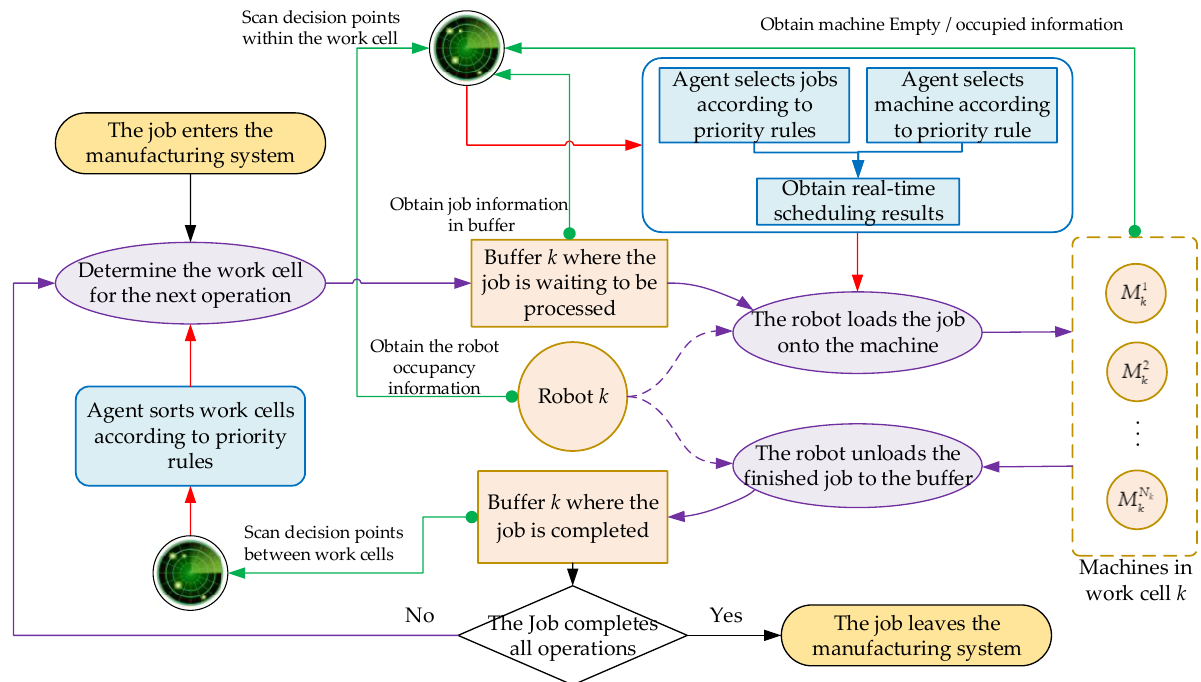
Figure 3. Execution process of scheduling decision.